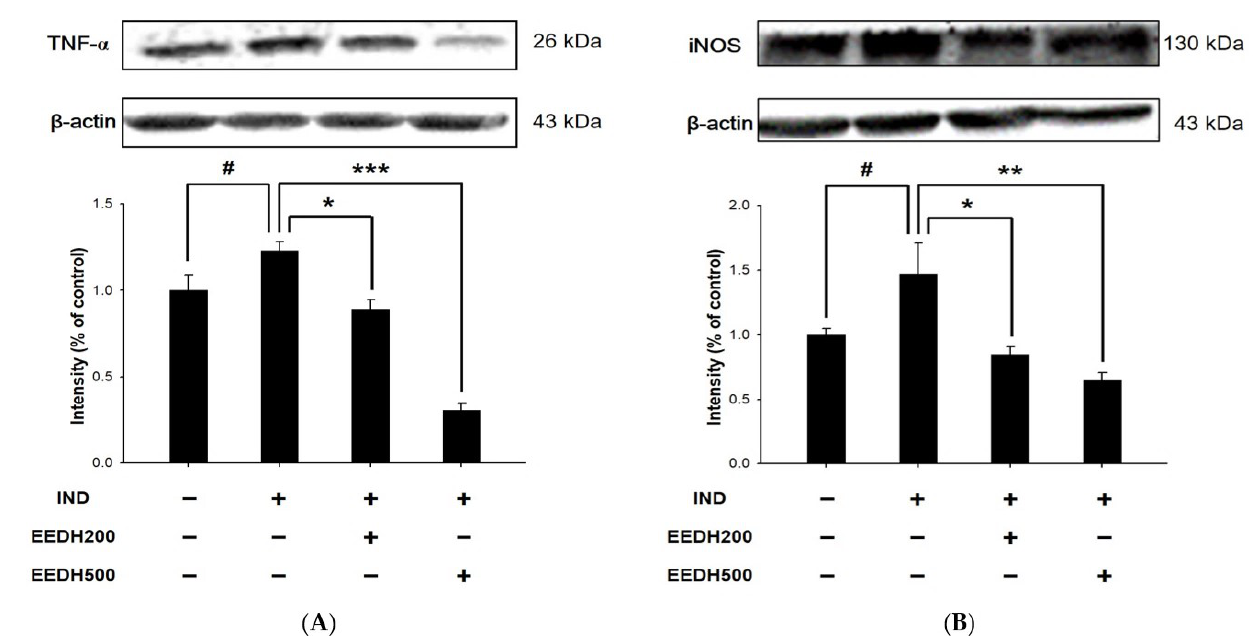
Figure 5. Effects of EEDH pretreatment on the protein levels of TNF- α ( A ) and iNOS ( B ) of gastric mucosa in mice administered with IND. Western blot was applied to determine the expression of TNF- α and iNOS. Data are represented as means ± SD ( n = 3). # p < 0.05 compared with control group. * p < 0.05, ** p < 0.01, and *** p < 0.001 compared with IND-treated